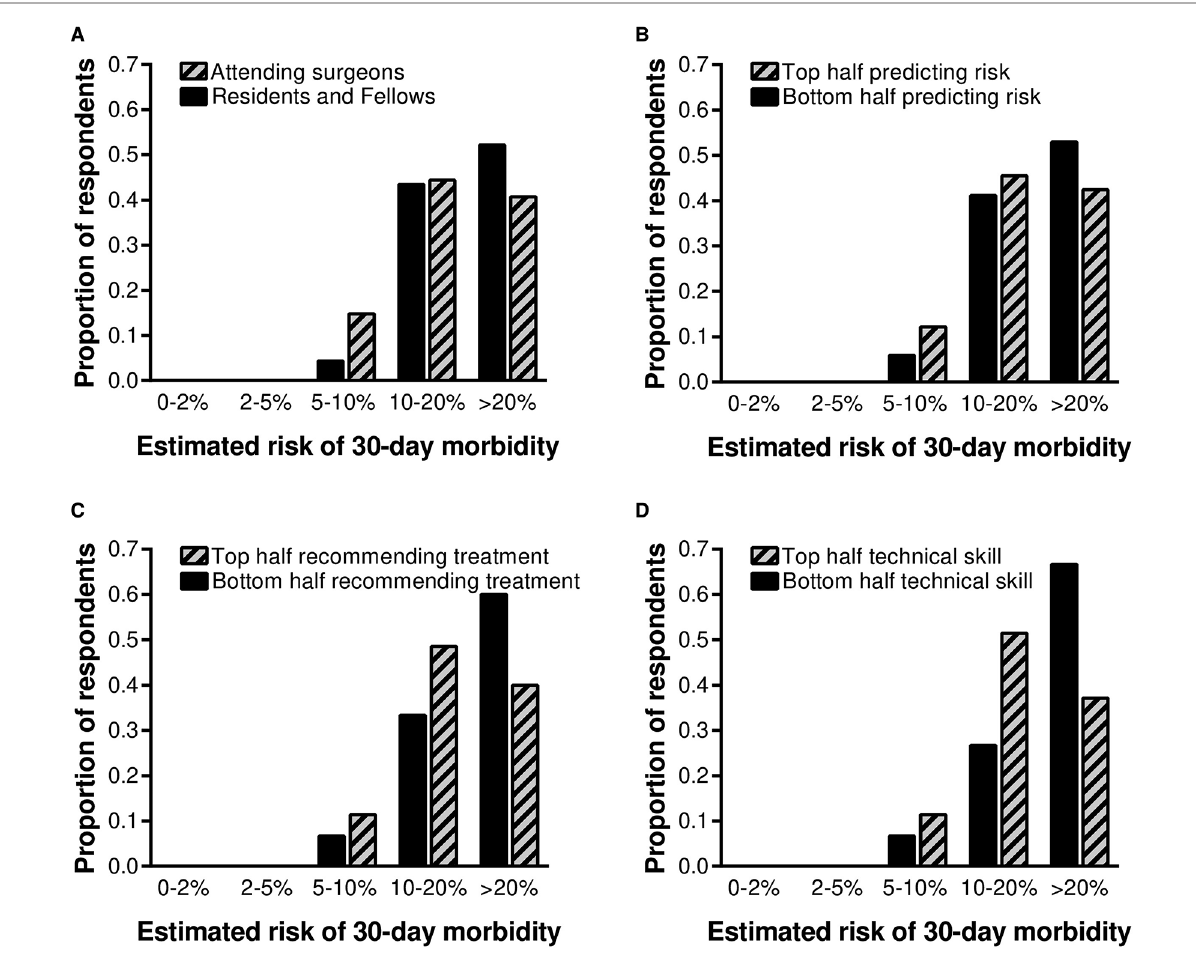
FIGURE 4 Predicted postoperative morbidity was strati fi ed by professional rank and self-identi fi cation as being in the top half of one ’ s peer group in predicting complications, making treatment recommendations, and technical skills. Thirty-seven percent of all surgeons who self-identi fi ed as top half for technical skills predicted a high (>20%) chance of serious complications following laparoscopic cholecystectomy, compared with 67% of all surgeons who self-identi fi ed as bottom half for technical skills ( p